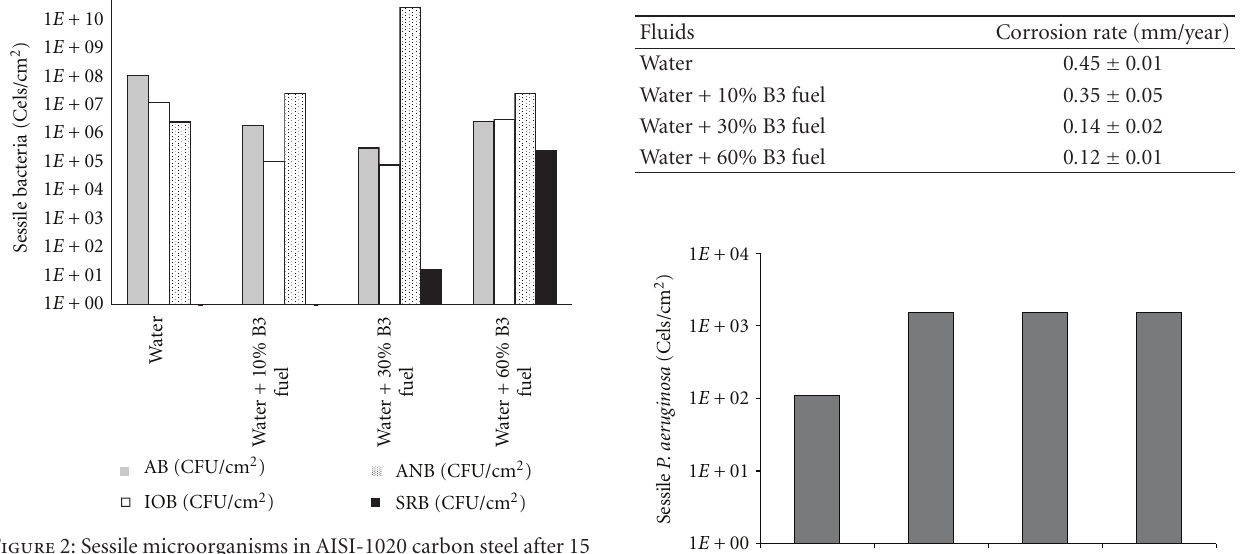
Table 2: Corrosion rates as a function of the B3 fuel concentrations.